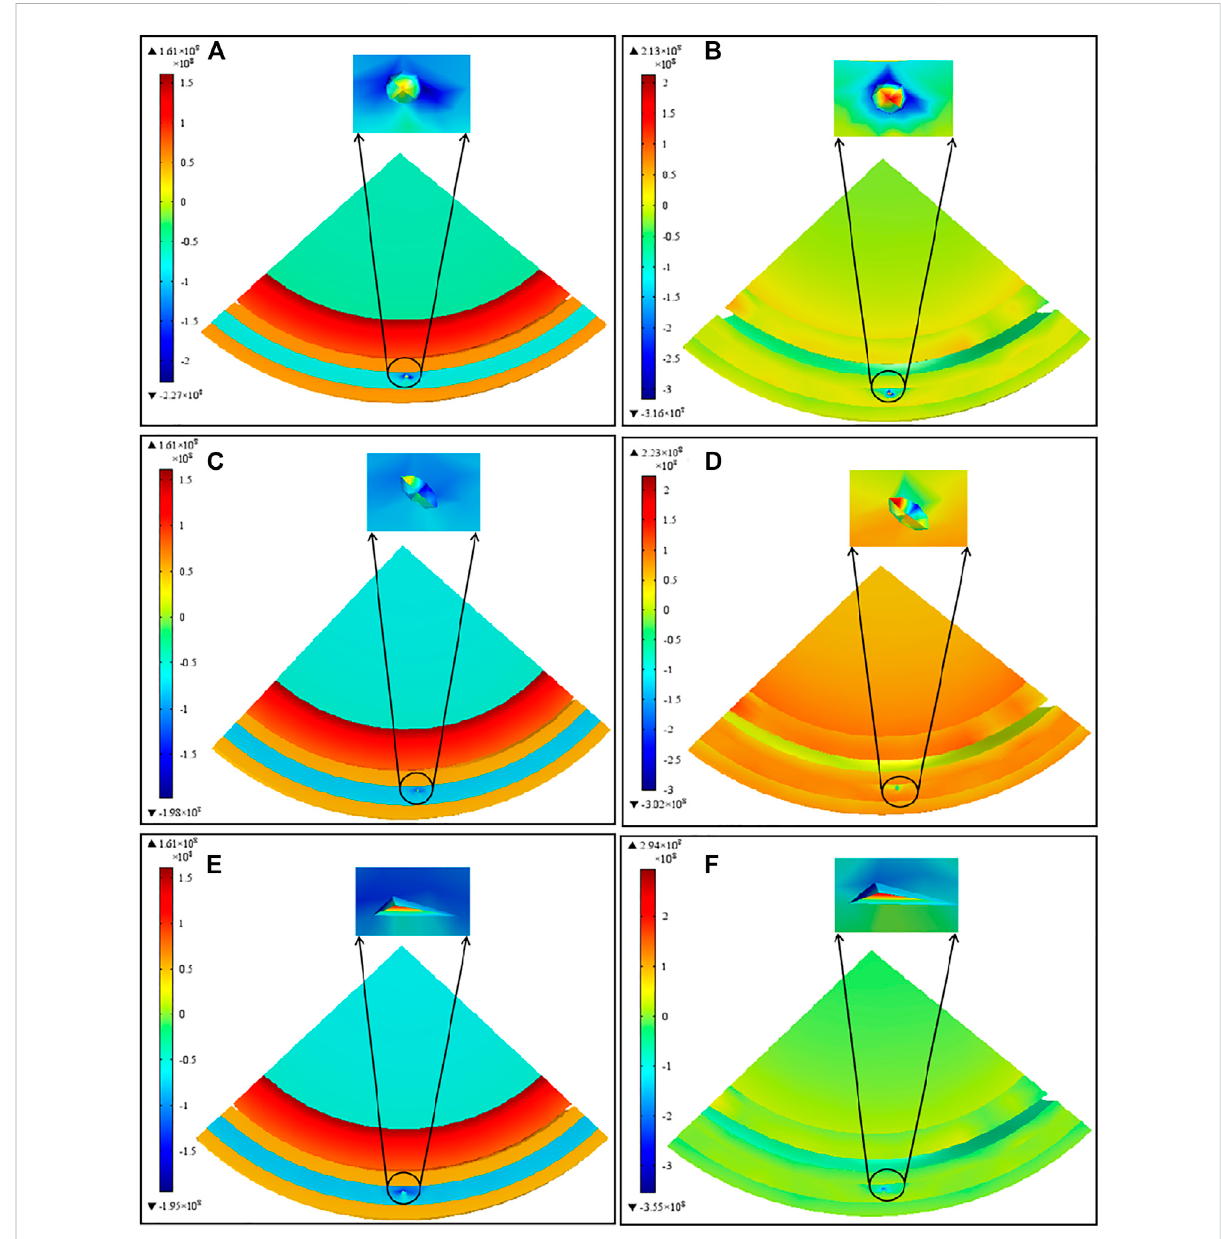
FIGURE 5 Contour plots of the tangential stress for a TRISO particle with different residual pore sizes. (A,B) are the spherical pores at the beginning and end of the operation time, (C,D) are ovoid pores at the beginning and end of the operation time, (E,F) are the tetrahedral pores at the beginning and end of operation